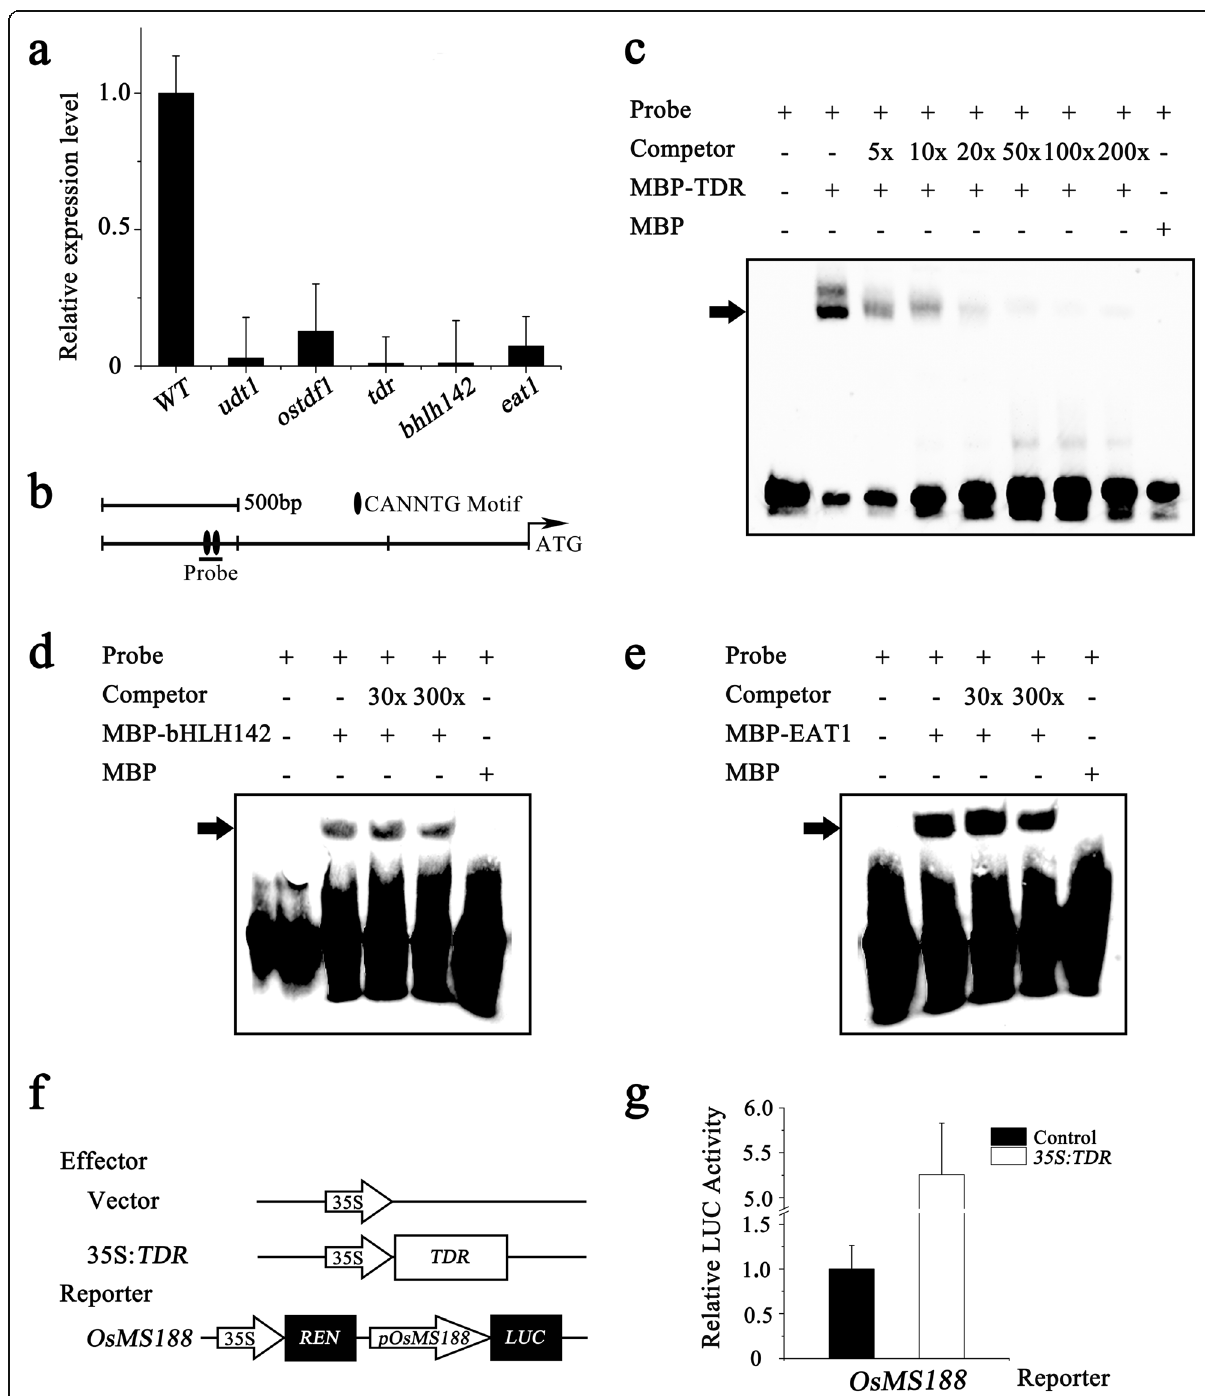
Fig. 5 TDR directly binds and activates the expression of OsMS188 . a QRT-PCR analysis of OsMS188 expression in the inflorescences of the WT, udt1 , ostdf1 , tdr , bhlh142 and eat1 . b Potential binding sites of bHLH transcription factors in the OsMS188 promoter region. The black dots indicate the CANNTG motif. c EMSAs showing that TDR binds to the fragment of the OsMS188 promoter region. The MBP-tagged TDR proteins were mixed with a biotin-labelled probe, and unlabelled probes were used as competitors. The arrowhead indicates a shifted band. d - e The abundance of the shifted band was not reduced by unlabelled competitor probes mixed with bHLH142 and EAT1. f - g Transient dual-luciferase transactivation of the OsMS188 promoter by TDR in protoplasts. Three replicates were assessed, and the Y-axis shows the ratio of Luciferase/ Renilla. The errors bar indicate the